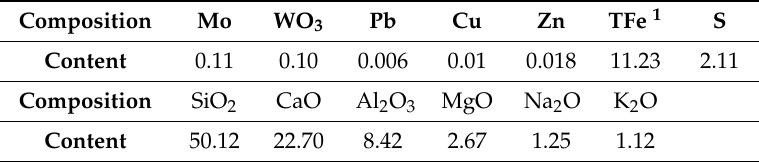
Table 1. The chemical composition analysis of the Mo ore (wt %).